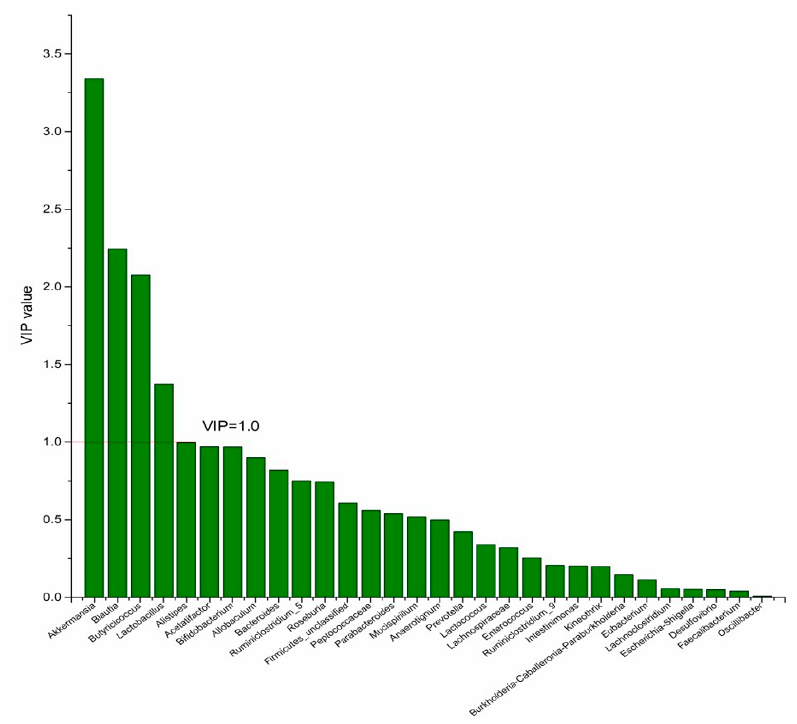
Figure 8. The VIP plot of the differential bacterial genera in DPA group vs. HC group.